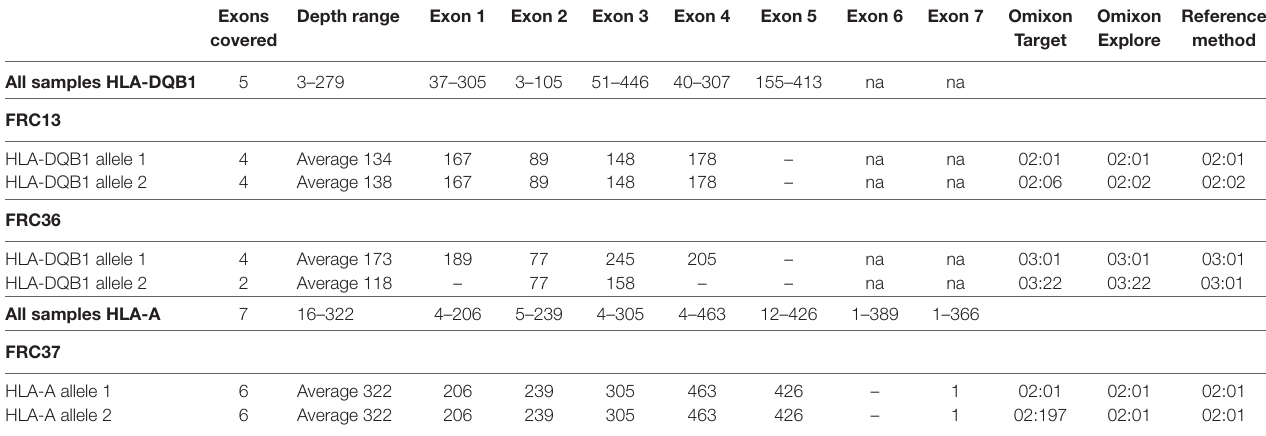
TaBle 2 | Sequencing depth and coverage in three samples with discrepant results in human leukocyte antigen (HLA) interpretation by the Omixon Explore